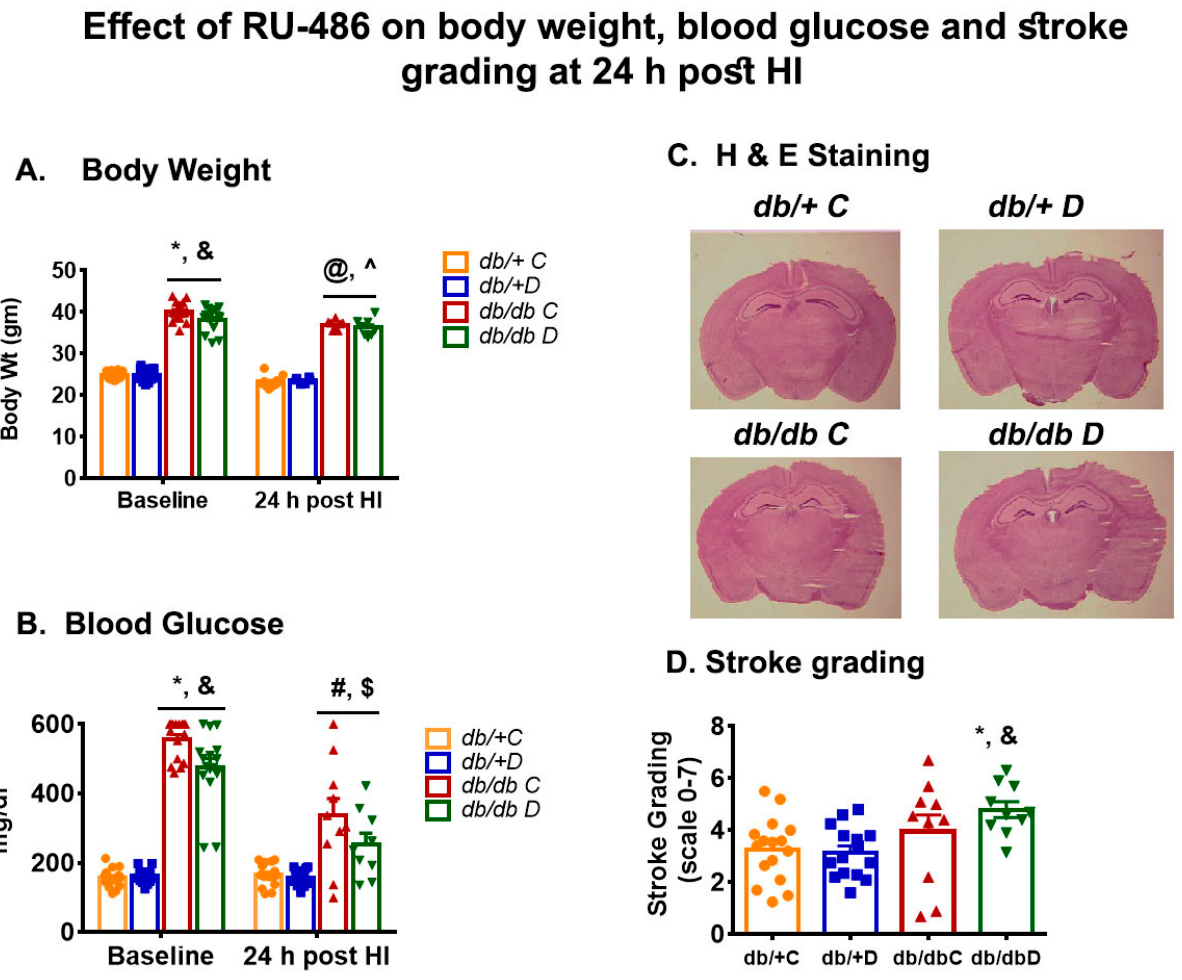
Figure 1. ( A , B ) shows the effect of RU-486 treatment on body weight and blood glucose in type-2 diabetic db / db and non-diabetic db /+ at baseline and 24 h post-HI compared with their vehicle control. ( C ) shows the representative image of H & E staining at hippocampal level and ( D ) shows the stroke grading following RU-486 treatment on infarct size in type-2 diabetic db / db and non-diabetic db /+. Values were shown as mean ± SEM and significance were set at p < 0.05. db /+C: vehicle control ( n = 8 to 16), db/ +D RU-486 treatment ( n = 6 to 15), db / db C: vehicle control ( n = 10 to16), db / db D: RU-486 treatment ( n = 6 to 10). * p < 0.05 vs. db /+C baseline: and & p < 0.05 vs. db /+D baseline: @ p < 0.05 vs. db /+ C post-HI: ˆ p < 0.05 vs. db /+D post-HI: # p < 0.05 vs. db/db C -baseline: $ p < 0.05 vs. db/db D baseline.